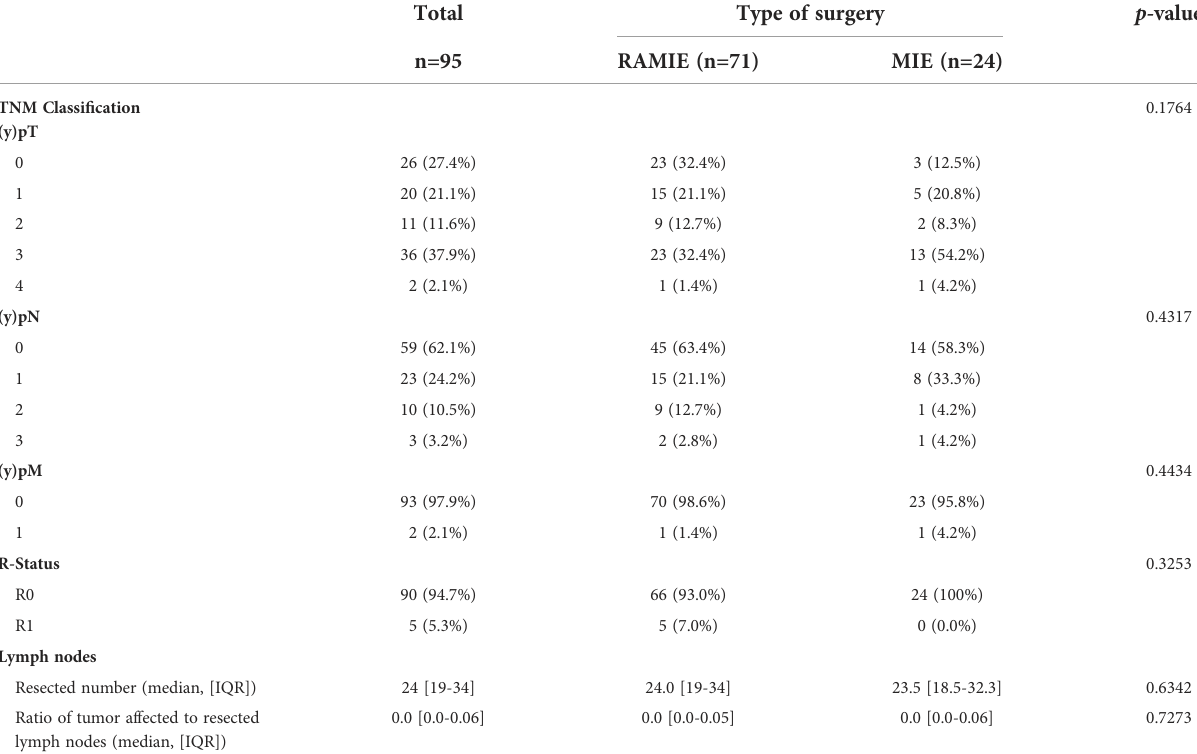
TABLE 2 Histopathological data.